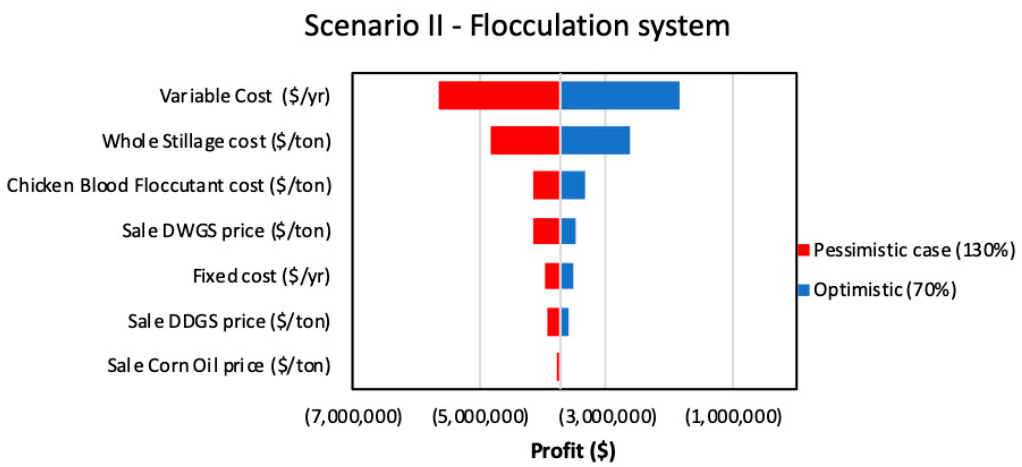
Figure 8. Sensitivity analyses of flocculation system as a function of DDGS, DWGS, and corn oil prices from − 30% (pessimistic case) to + 30% (optimistic).